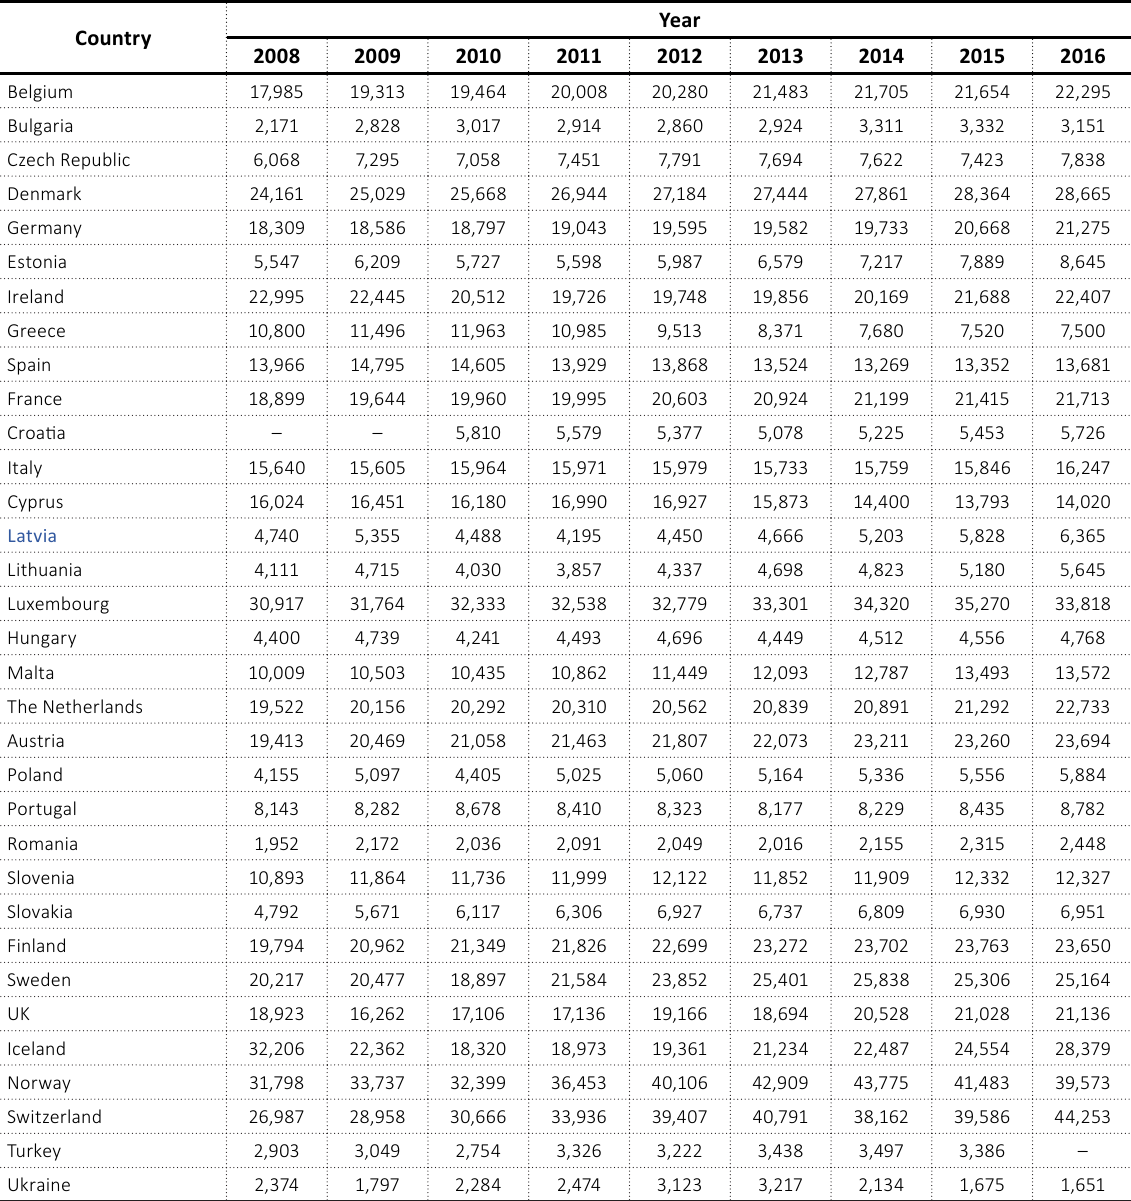
Table 3. Dynamics of average income in EU member states and Ukraine in 2008–2016, Euro per